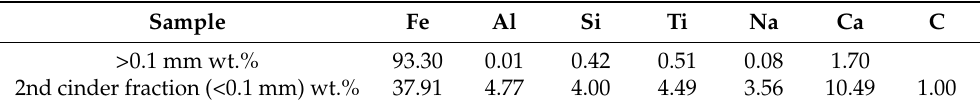
Table 6. Chemical analysis of the metallic iron spheres fraction with a particle size > 0.1 mm and of the fraction with a particle size < 0.1